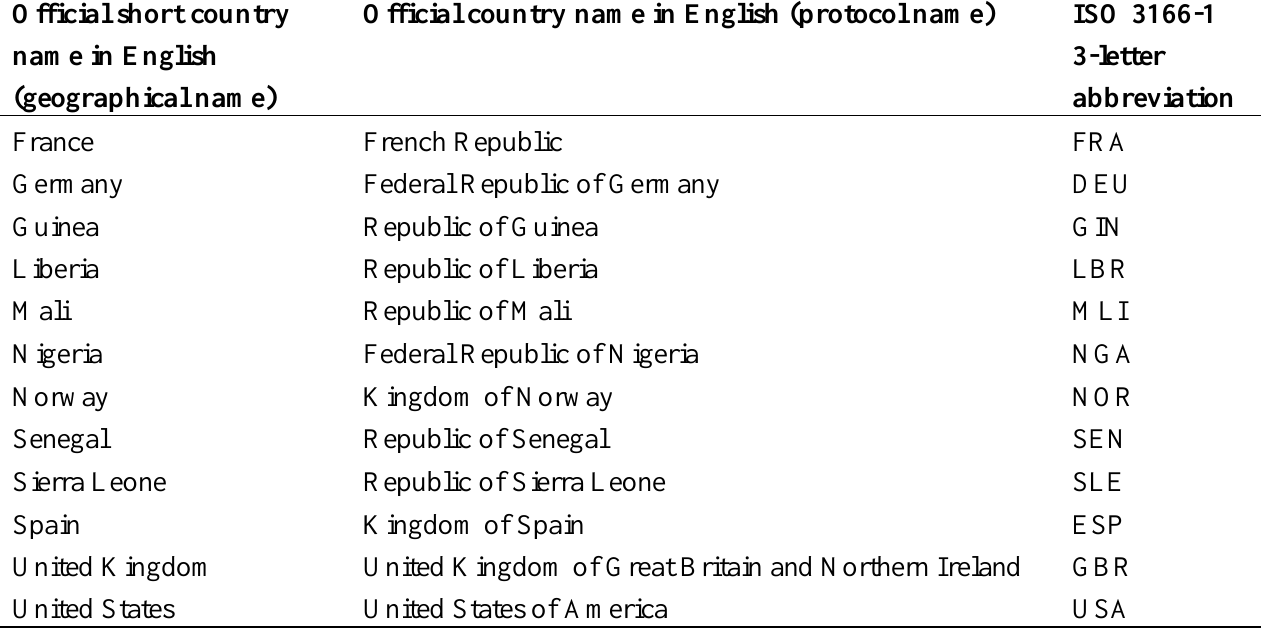
Table 2. ISO 3166-1 alpha-3 country codes for countries with recorded cases connected to the 2014 EVD epidemic that started in Guinea [23]: